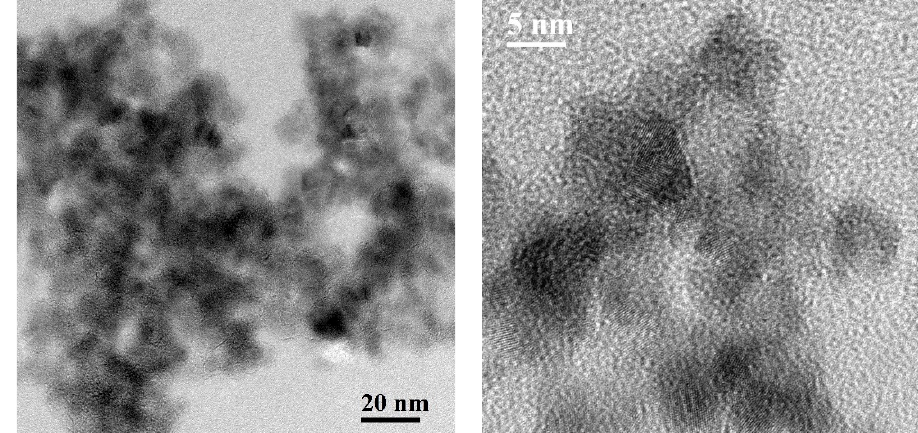
Figure 1. On the left, transmission electron microscopy (TEM) image of plasma treated Detonation nanodiamonds (DNDs); on the right, an enlarged picture at a border of an agglomerate showing some individual particles.